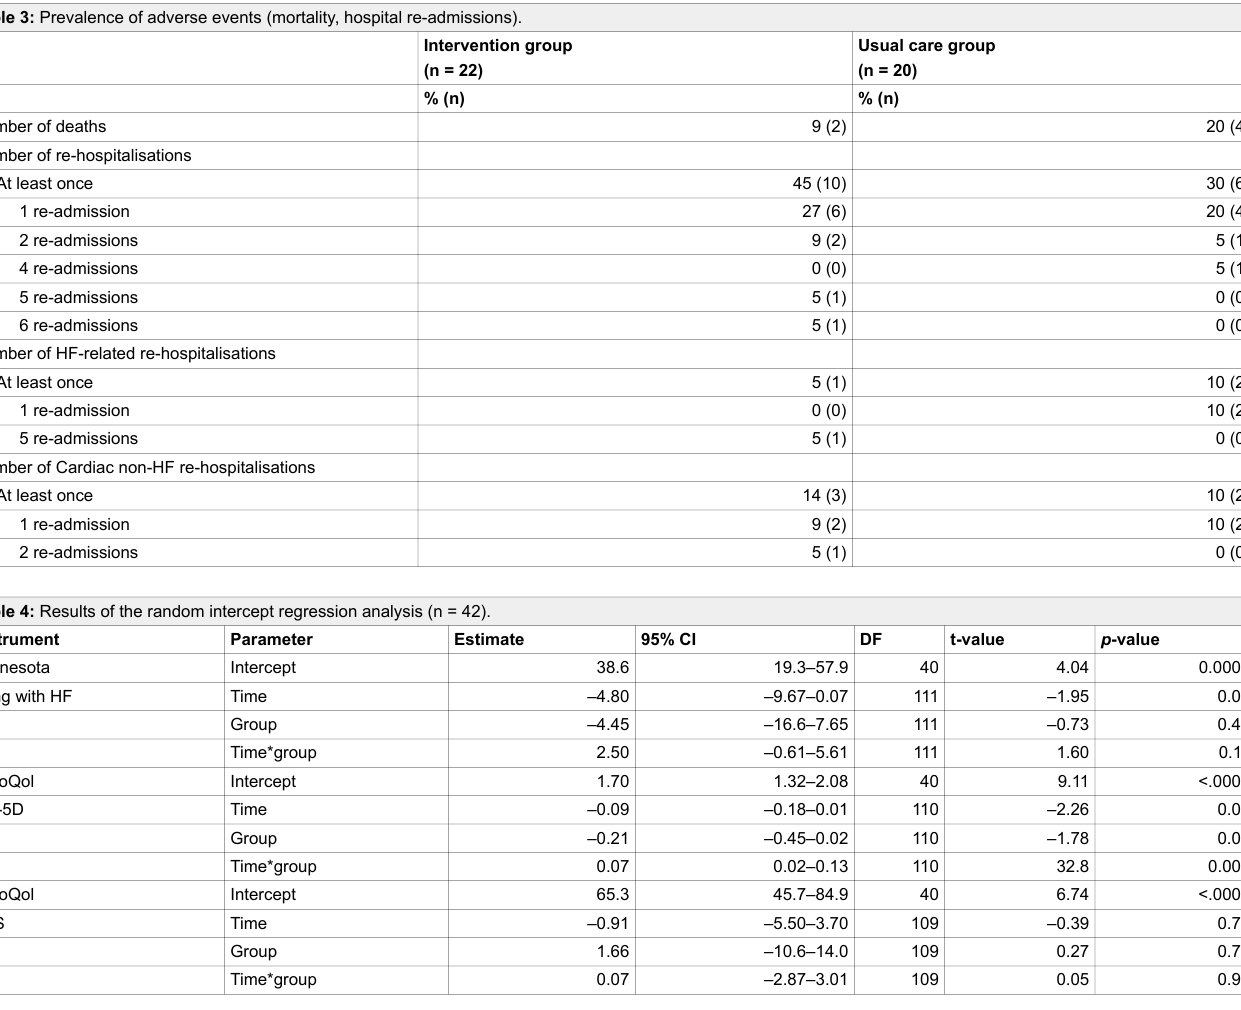
Table 3: Prevalence of adverse events (mortality, hospital re-admissions).